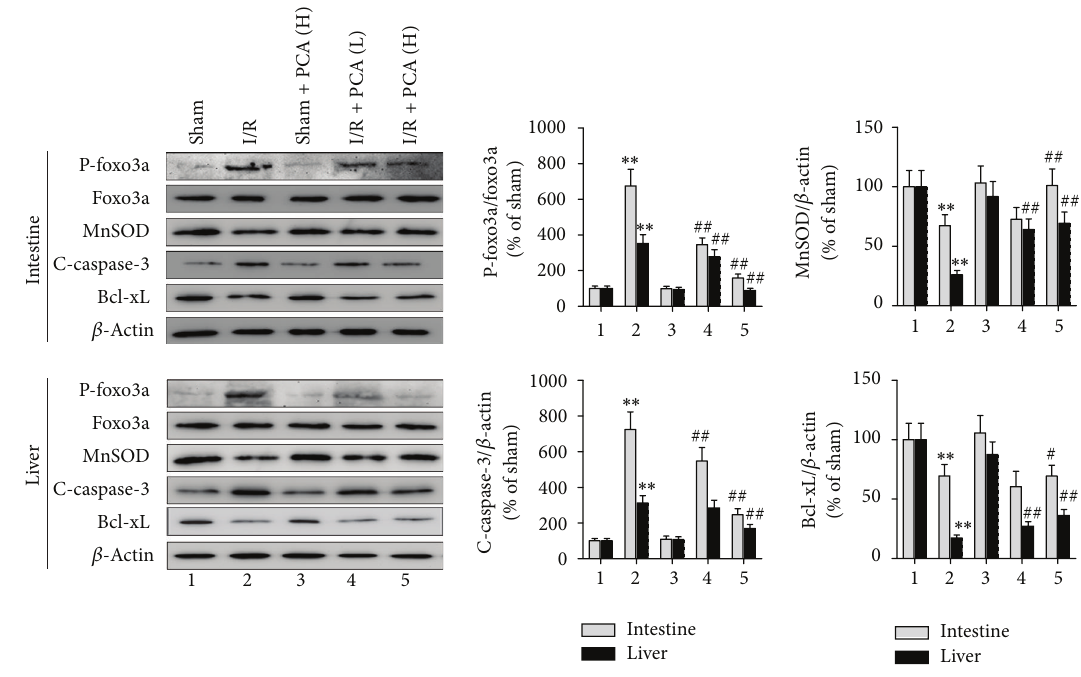
Figure 6: PCA pretreatment regulated the oxidative-stress regulators and apoptotic factors of p66shc pathway. Western blot analysis of phospho-foxo3a (p-foxo3a), foxo3a, MnSOD, cleaved-caspase-3 (C-caspase-3), and Bcl-xL in the intestine and liver. Results are presented as the mean ± SD, 𝑛 = 3 . ∗∗ 𝑃 < 0.01 versus sham group; # 𝑃 < 0.05 versus I/R group; ## 𝑃 < 0.01 versus I/R group. 1 indicates Sham; 2, I/R; 3, Sham + PCA (H); 4, I/R + PCA (L); 5, I/R + PCA